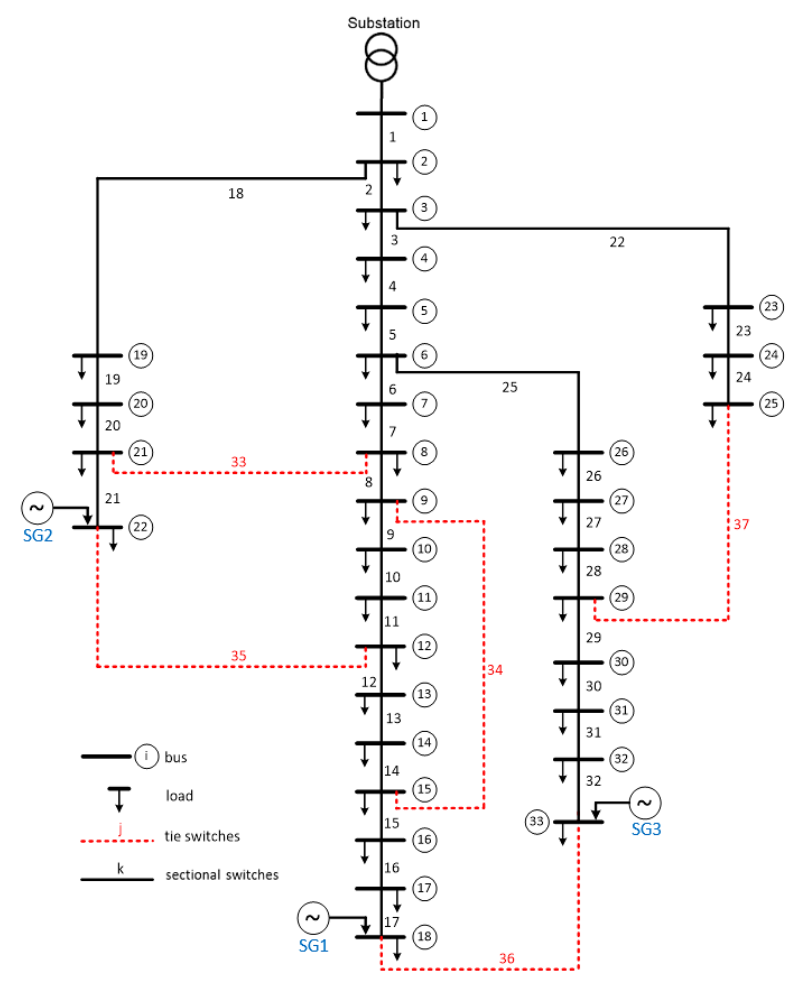
Figure 4. Installation of three SGs on IEEE model distribution network